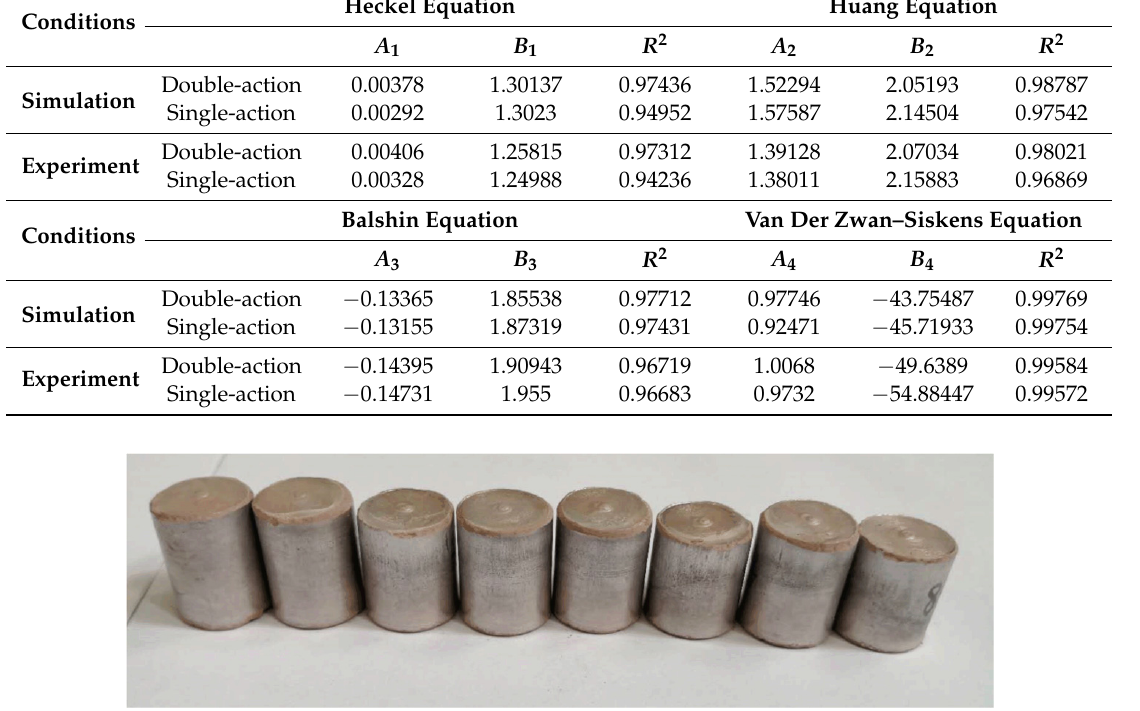
Figure 7. The Cu–Al 30 wt % mixed powder compact specimens.